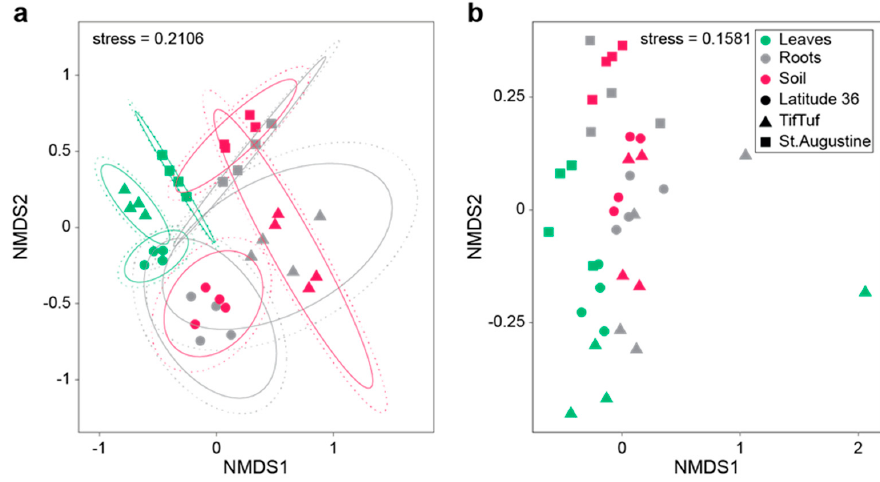
Figure 2. Non-metric multidimensional scaling plot of microbial communities (( a ), fungi; ( b ), bacteria) associated with different microhabitats (colored) on two equally managed cultivars of bermudagrass (Latitude 36 and TifTuf), and an adjacent St. Augustinegrass managed by simulating typical homeowner care.